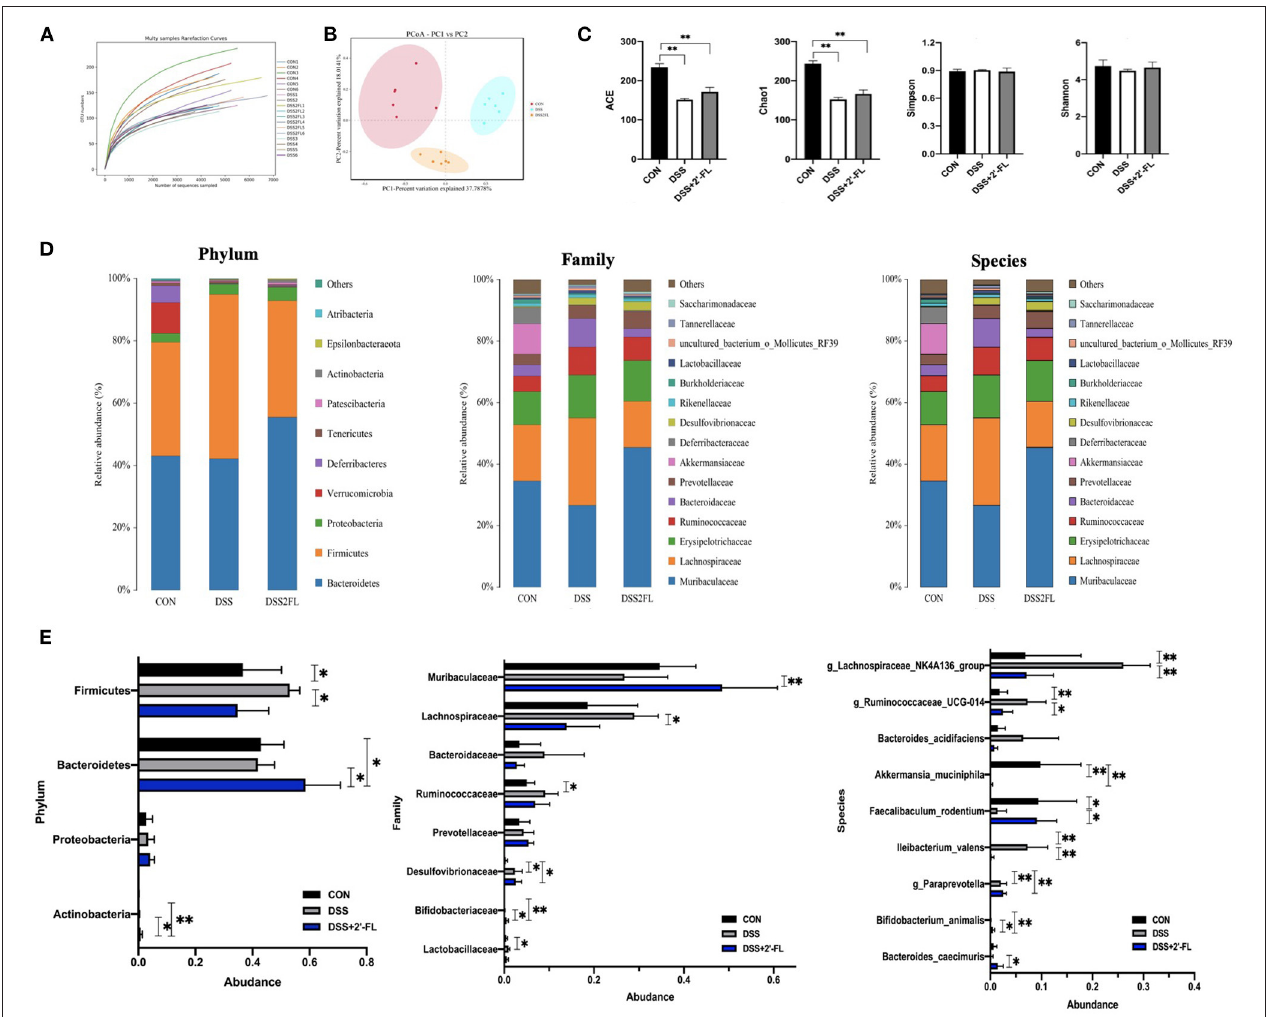
FIGURE 5 | Gut microbiota composition changes in response to the stimuli of colitis and 2 ′ -FL. (A) Multi samples rarefaction curve; (B) Principal coordinate analysis (PCoA) using the Bray–Curtis metric distances of beta diversity. (C) Alpha diversity (ACE, Chao1, Simpson, and Shannon index); (D) Stacked bar plots of species distribution at phylum, family, species levels, respectively. (E) Representative significantly changed bacteria in phylum, family, species levels across groups. Significance was determined using one-way ANOVA analysis and expressed as mean ± SEM. * p < 0.05; ** p <